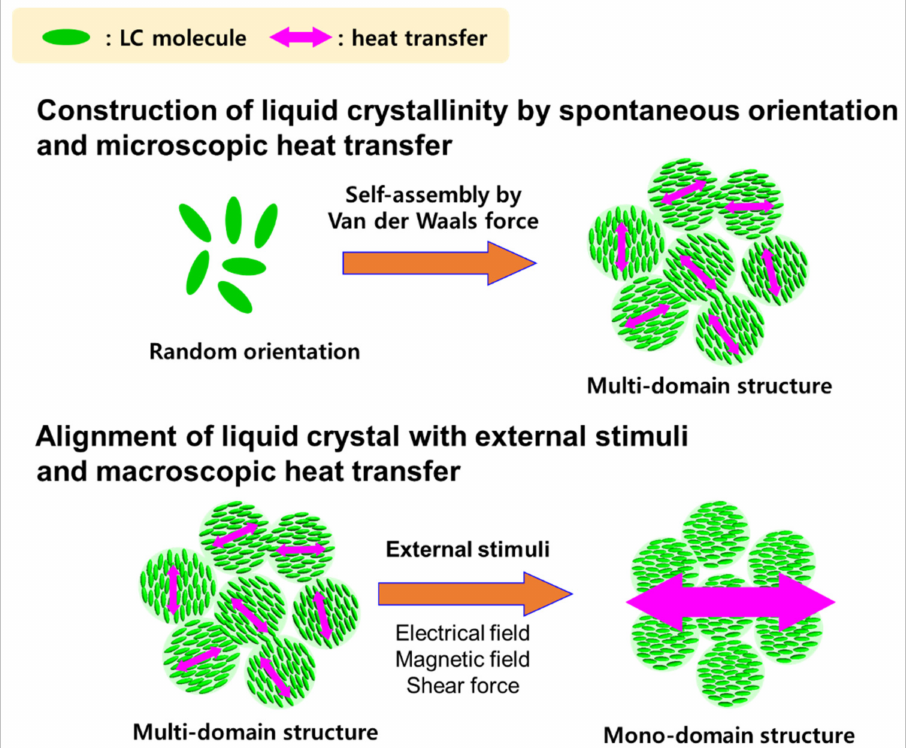
Figure 1. Schematic explanation of correlation between liquid crystal structure and thermal